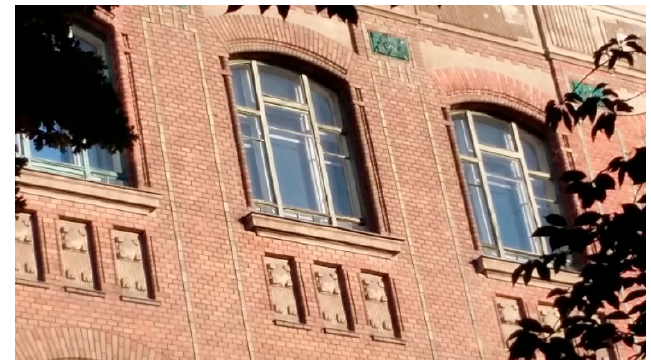
Figure 3. The original box-type window of the Central Building.